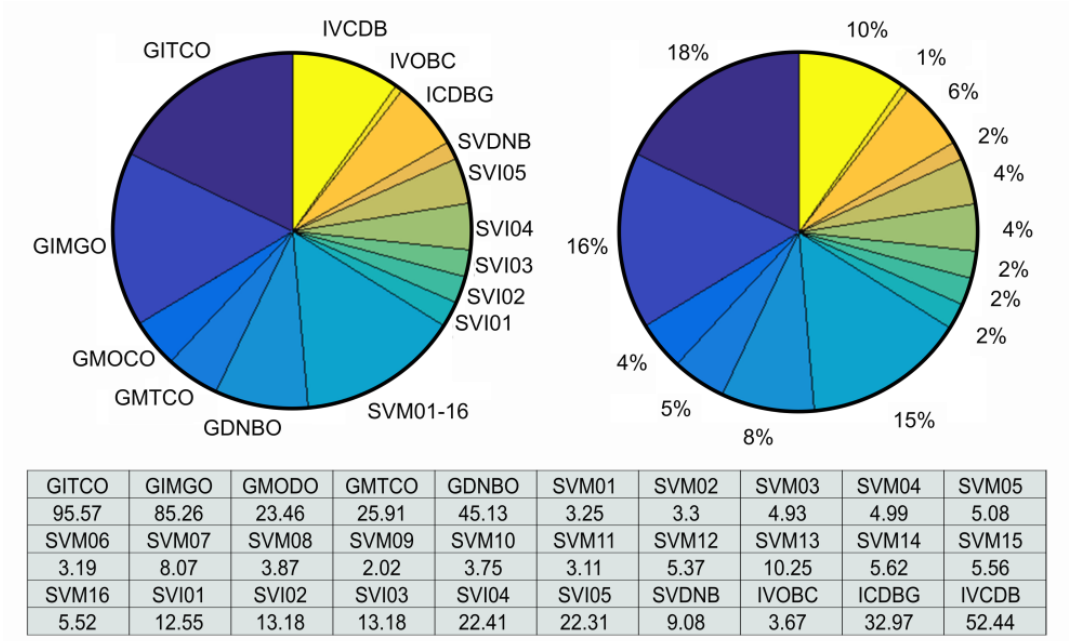
Figure A3. Daily VIIRS SDR Average Data Volume (GB) for each type of SDR file (1013 granules).